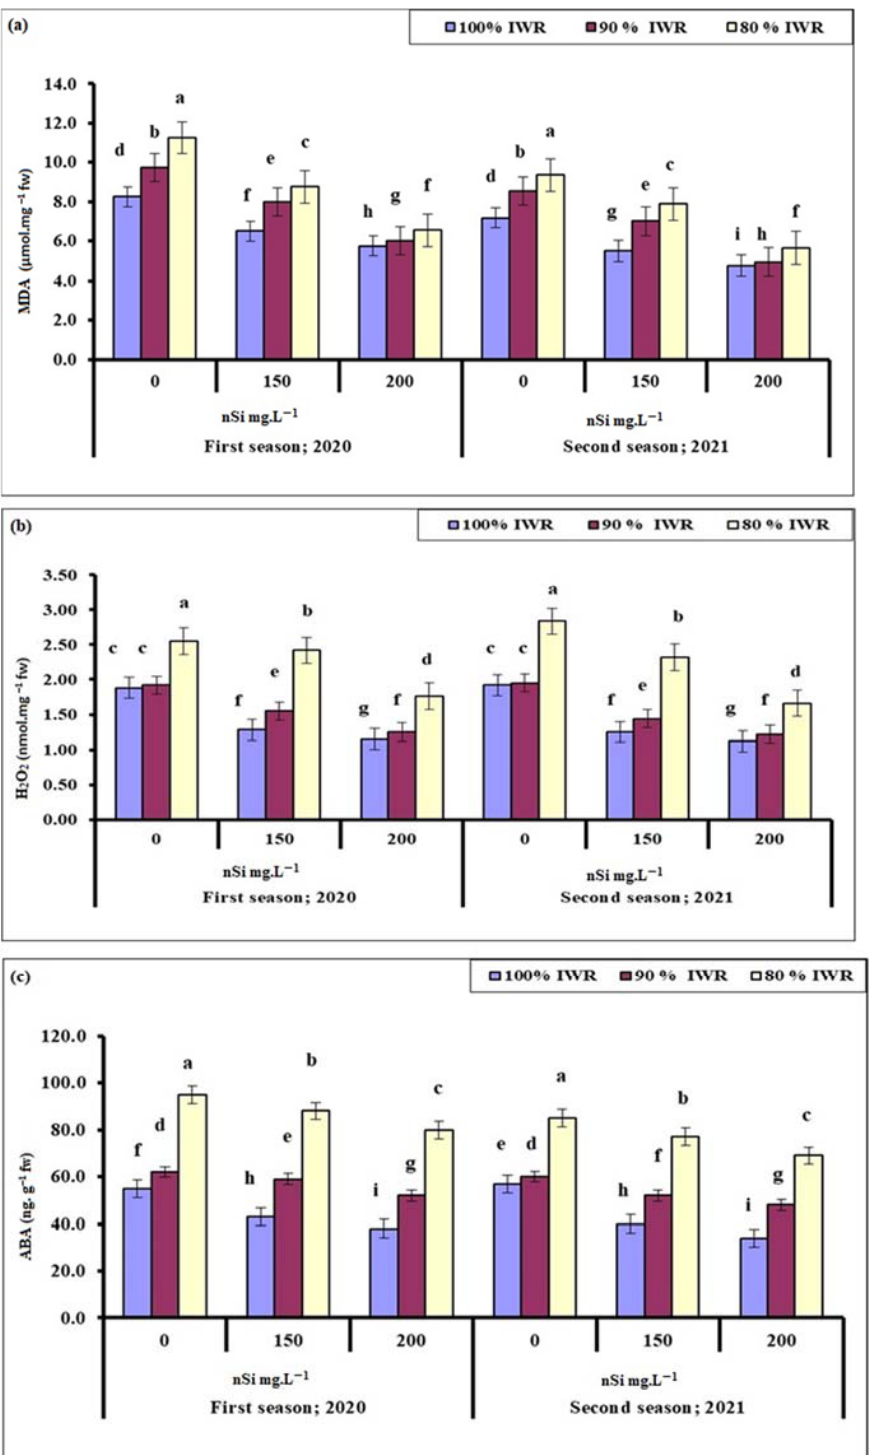
Figure 4. Effect of foliar sprayed nano-silicon (nSi) under different irrigation regimes on the leaf malondialdehyde ‘MDA’ ( a ), H 2 O 2 ( b ), and abscisic acid ‘ABA’ ( c ) contents of ‘Kalamata’ olive trees during the 2020 and 2021 seasons ( n = 10). Means with similar letters for each season are not significantly different, using Duncan’s multiple range test (DMRT) at p ≤ 0.05. Error bars represent the standard error of the means.